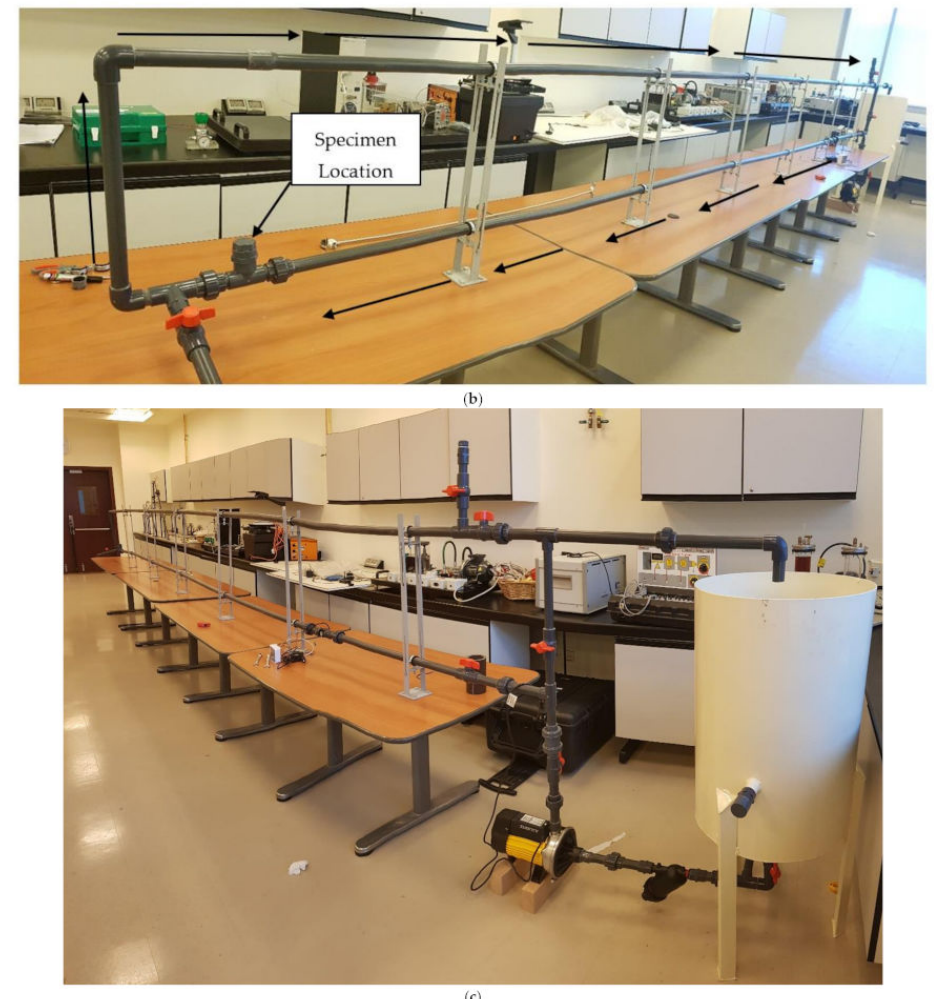
Figure 2. ( a ) Schematic diagram of the flow Loop, ( b ) flow direction and specimen location, ( c ) actual installed flow